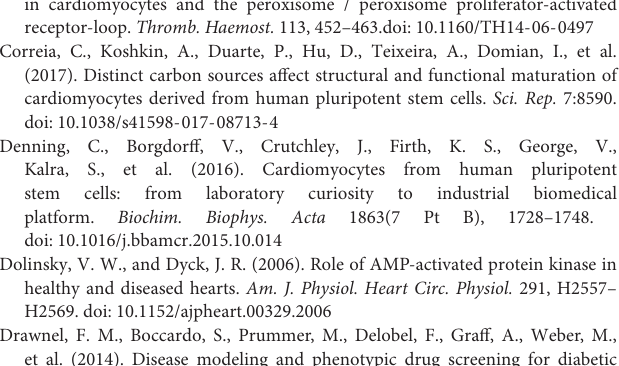
Supplementary Table 1 | Primer sequences for Quantitative Real-time PCR. Supplementary Table 2 | The antibodies used for Immunofluorescence and Western